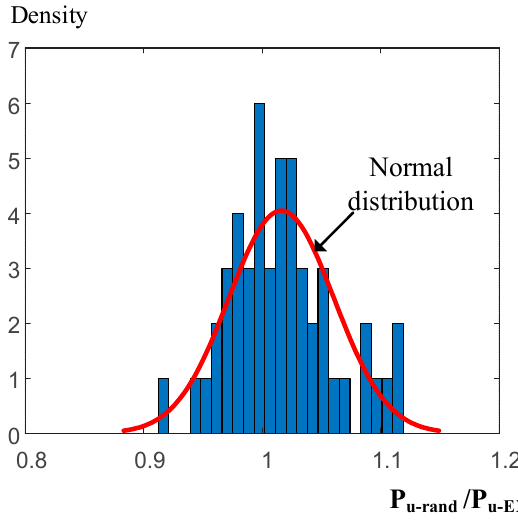
Figure 11. Histograms of P u-rand / P u-EXP for R1L1200.